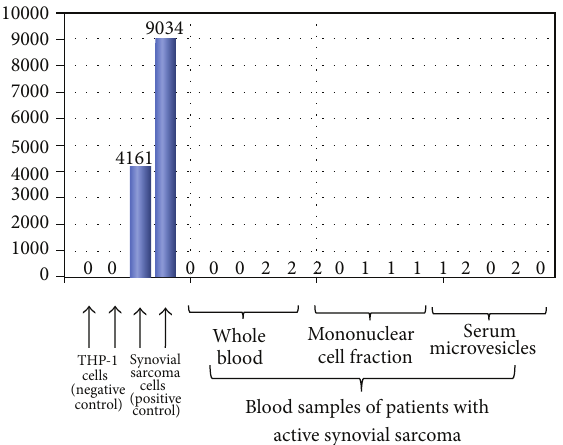
Figure 8: Analysis of the presence of the SYT-SSX fusion gene in whole blood, the mononuclear cell fraction, and serum microvesi- cles of synovial sarcoma patients by